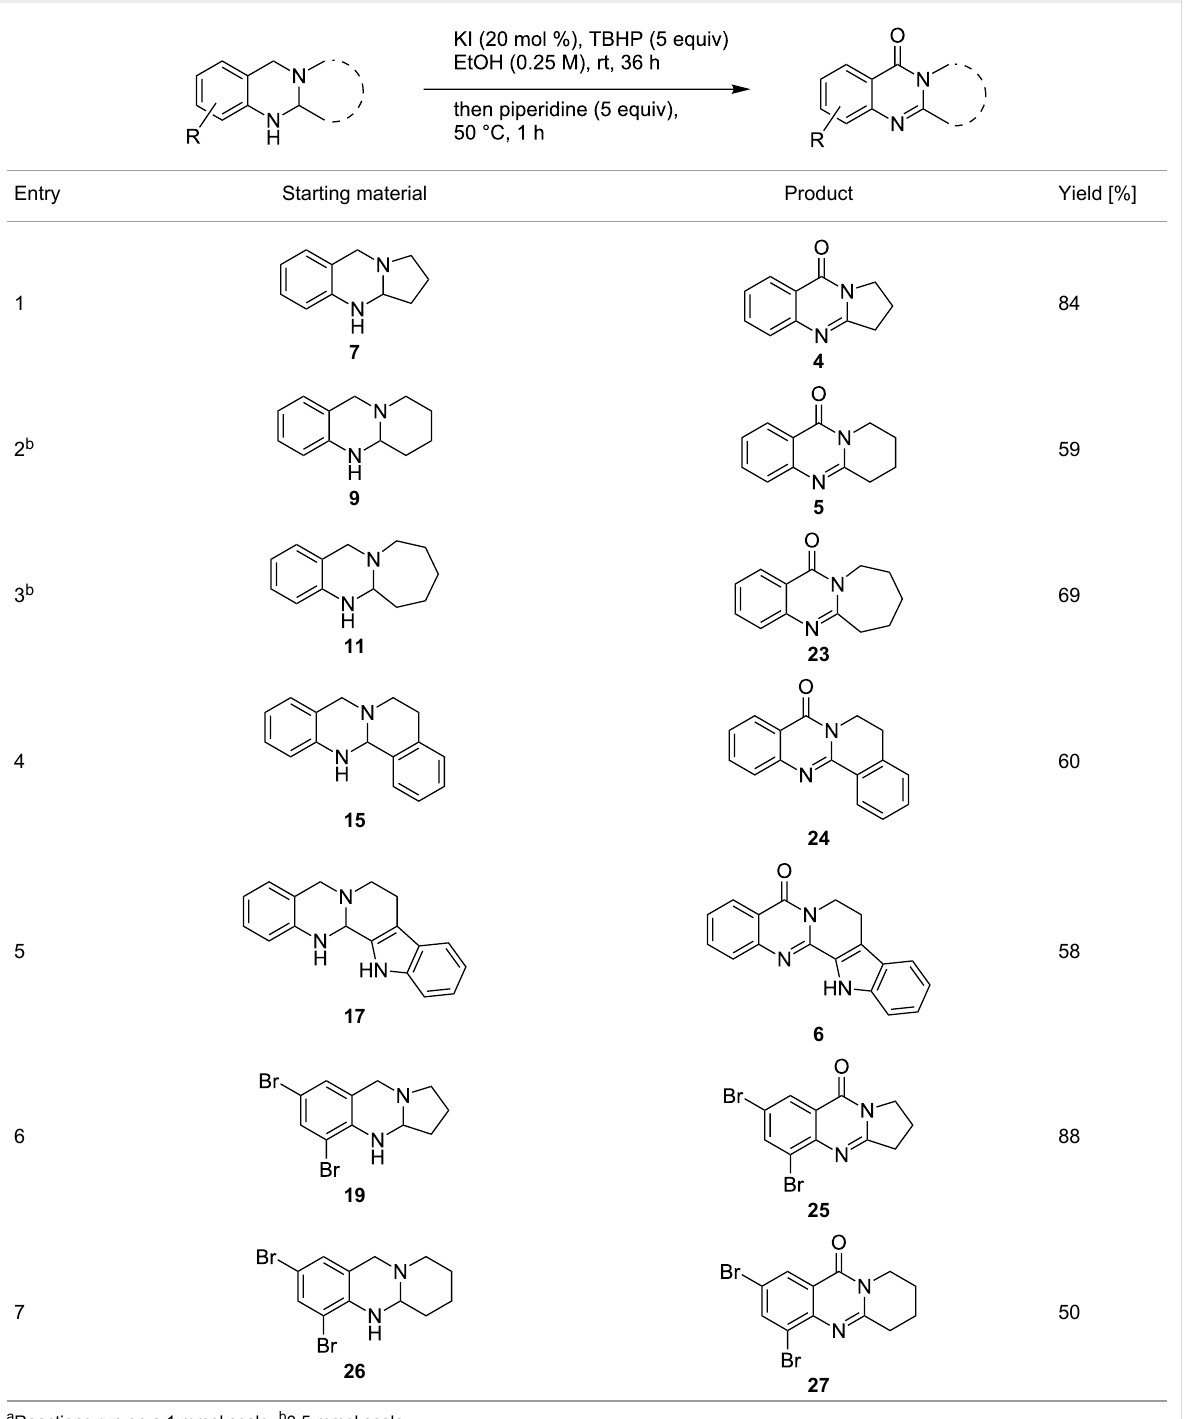
Table 4: Scope of KI-catalyzed conversion of aminals to quinazolinones.